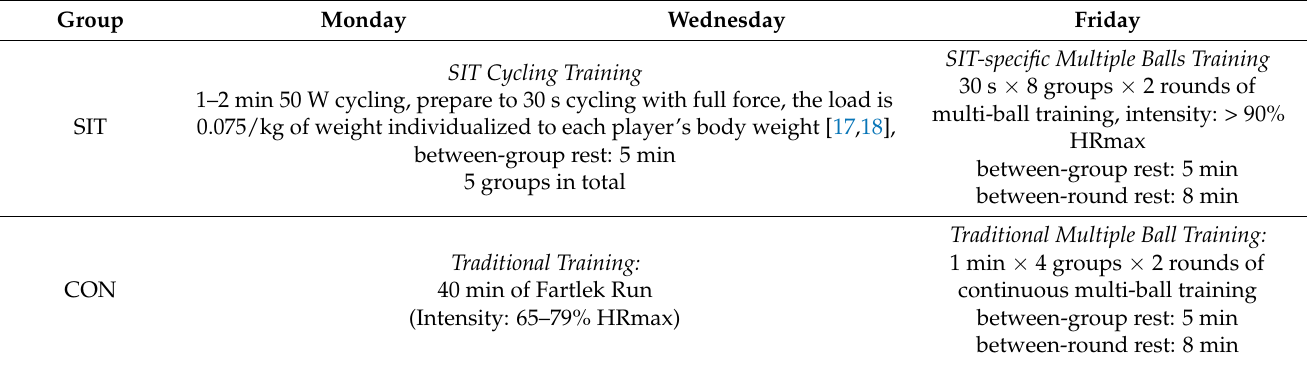
Table 2. Weekly training plan for two groups during the